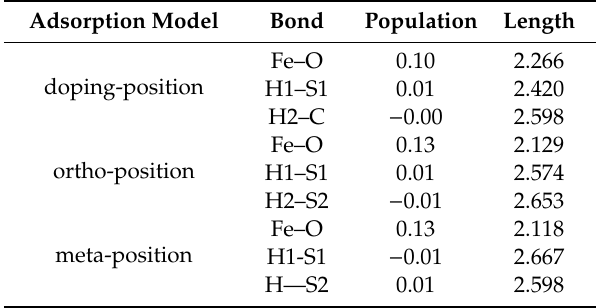
Table 3. Mulliken population after H 2 O adsorption on di ff erent sites of the coal pyrite surface. Adsorption Model